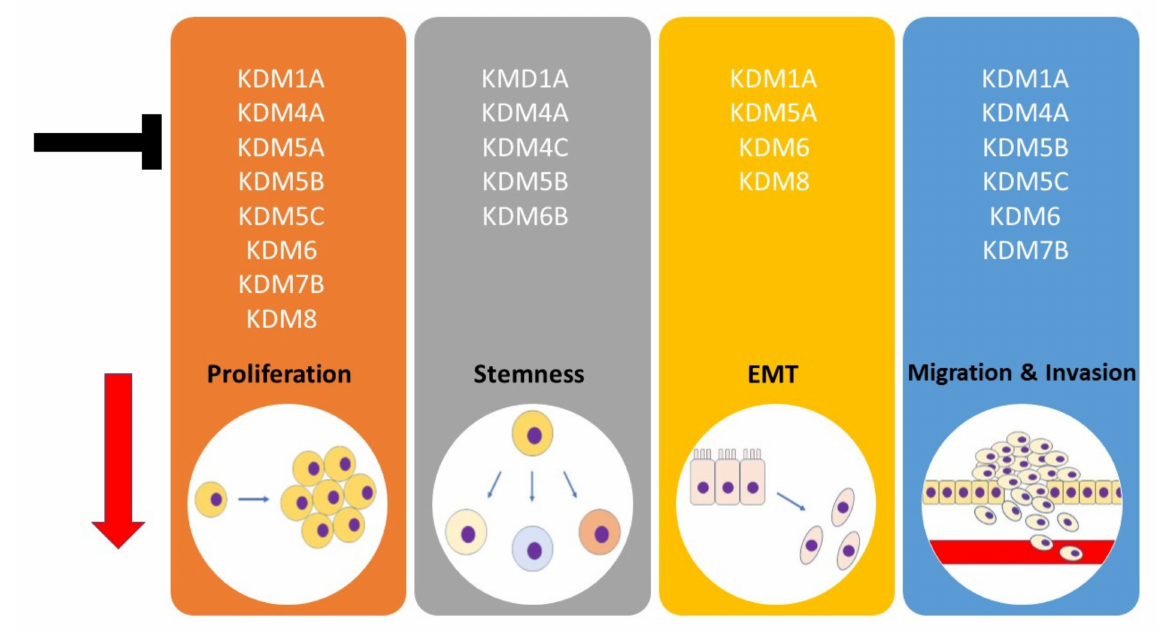
Figure 1. The effects of KDM inhibition or knockdown on critical HNSCC hallmark